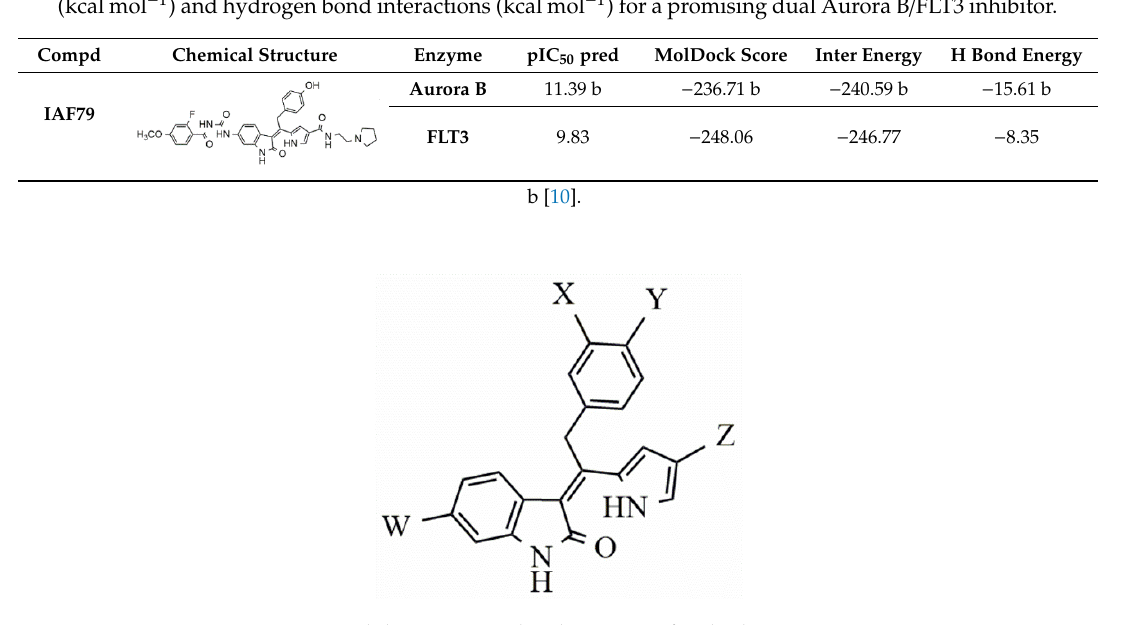
Table 5. Chemical structure, predicted pIC 50 , MolDock Scores (kcal mol − 1 ) of ligand-protein interactions